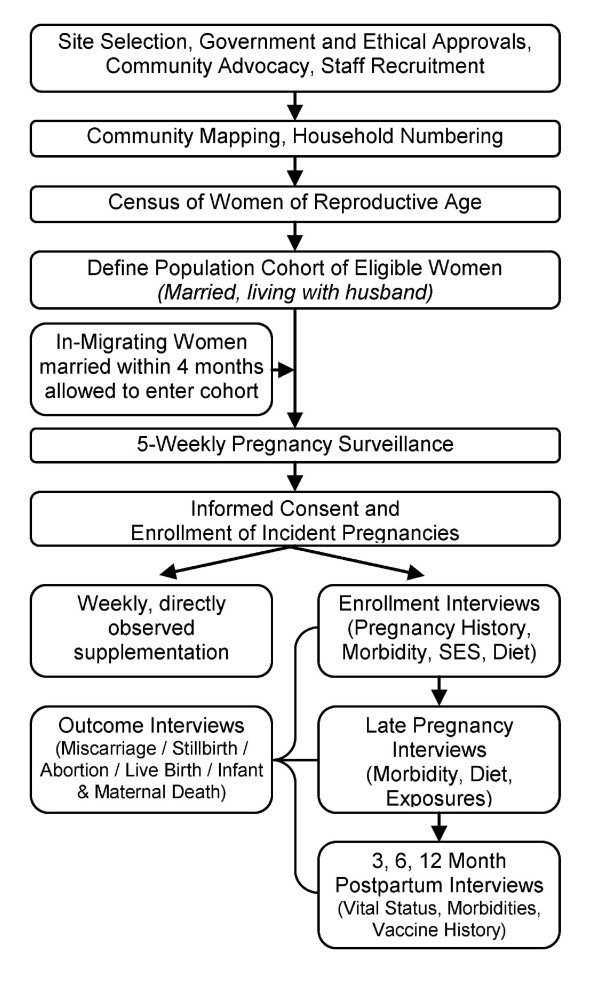
Flow diagram of main JiVitA-1 trial procedures.